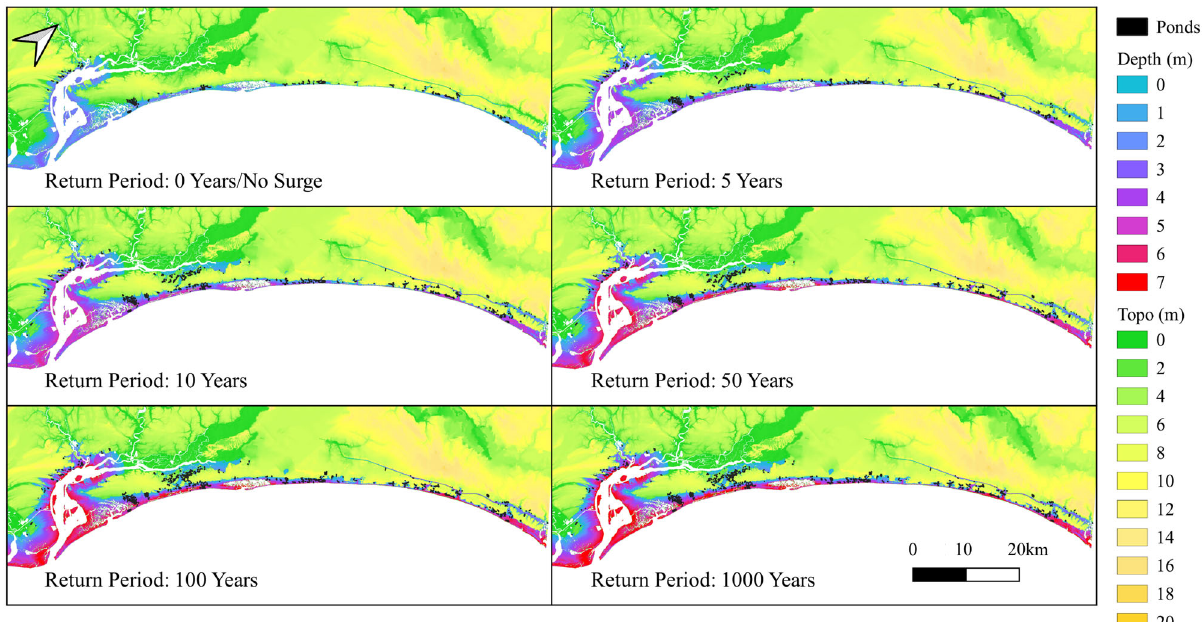
Figure 6. Long Bay area inundation map (blue–red) caused by storm surge heights with different return periods under an SLR scenario of 2.0 m. The SMPs at risk are marked as black shades.